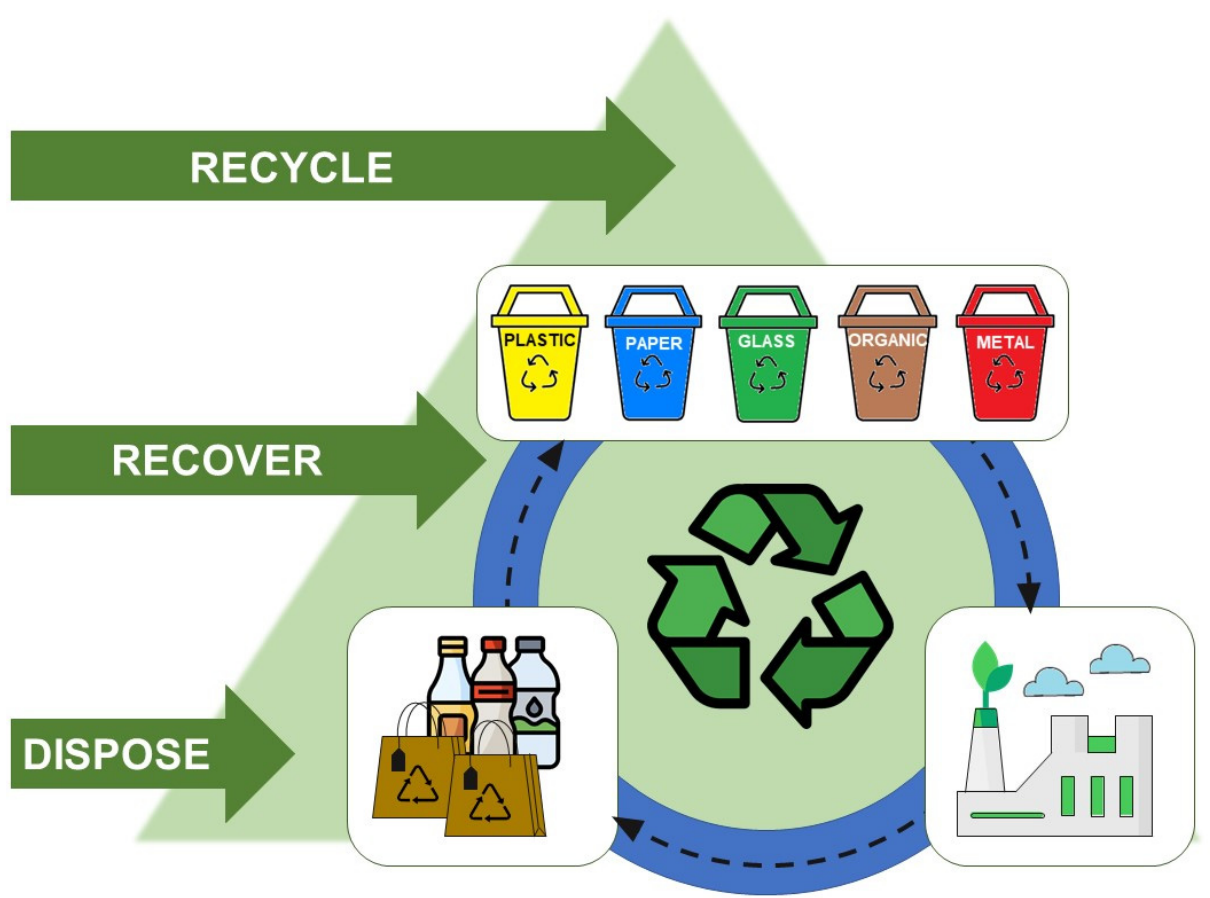
Figure 1. A very general view of waste material sources and waste management strategies, together with waste-processing cycle. By means of this illustrative pattern we emphasize the superiority of recycling strategy rather than disposal and recovery as other solutions provided to waste materials. Indeed, energy management have to be considered in realization of ‘green factory’ horizon shown in this scheme in addition to materials management.